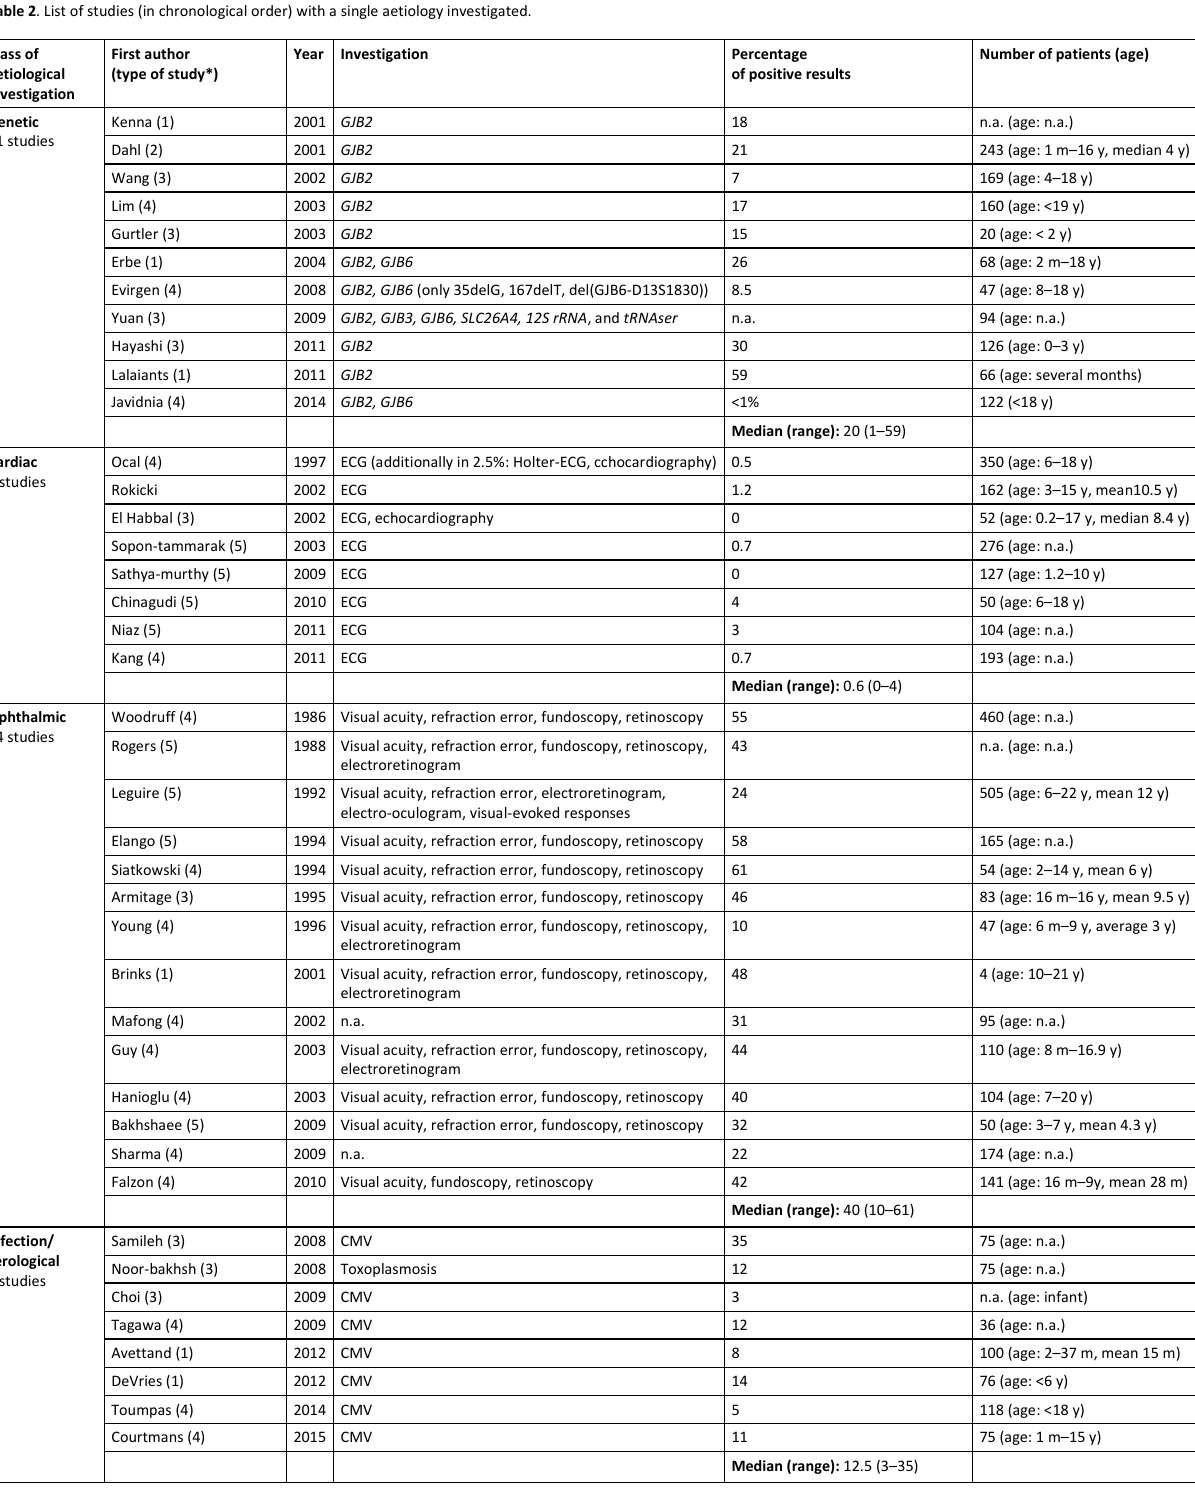
Table 2 . List of studies (in chronological order) with a single aetiology investigated. Class of aetiological